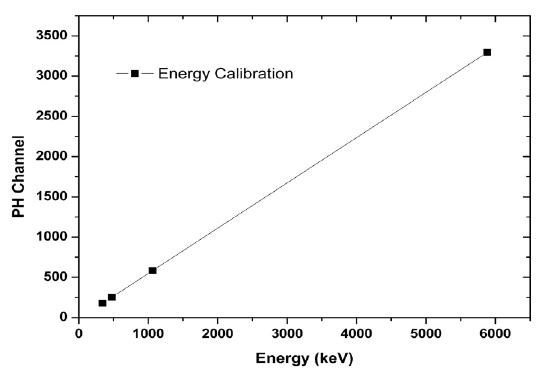
Fig.5 The fitting result of the deposited energy calibration